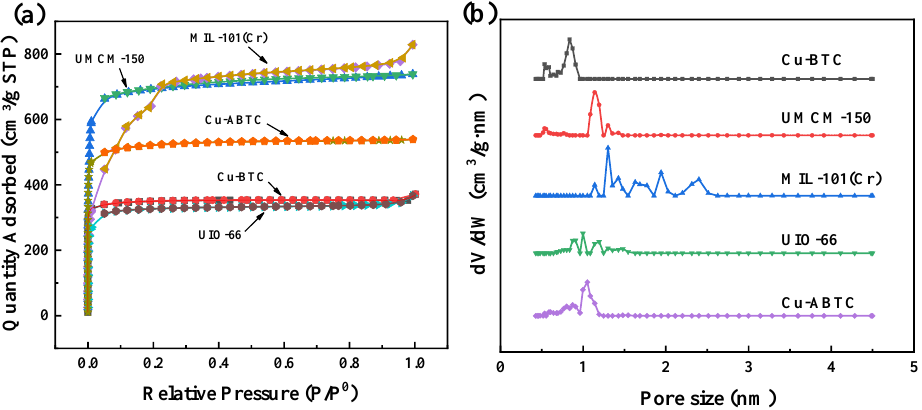
Figure 3. ( a ) Nitrogen adsorption-desorption isotherms and ( b ) NL-DFT pore-size distributions of the Cu-BTC, UMCM-150, MIL-101(Cr), UIO-66, and Cu-ABTC. Table 1. BET surface area and pore volumes of the five MOFs.